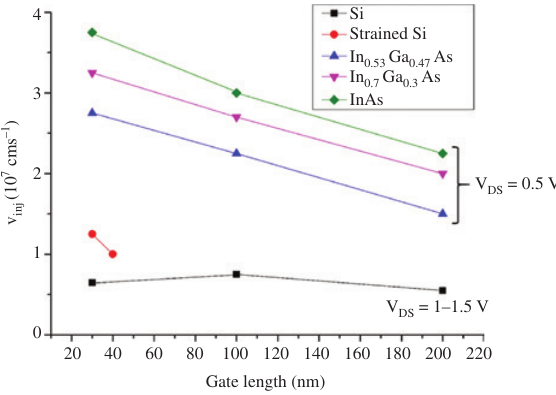
Figure 5: Source injection velocity for InAs HEMTs and silicon or strained-silicon FETs as a function of gate length